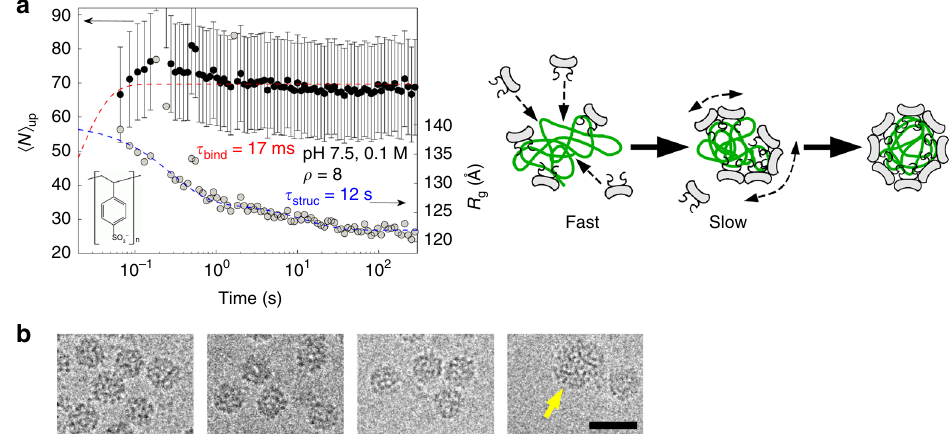
(black discs) and R g (light gray discs) vs. time after mixing subunits and 600-kDa poly(styrene Fig. 4 Self-assembly dynamics of PSS- fi lled capsids. a N h i up sulfonic acid) (PSS) at pH 7.5 with a fi nal ionic strength of 0.1 M. The subunit-to-PSS mass ratio was ρ = 8. The red and blue dashed lines are single and double exponential decay functions yielding τ bind and τ struc , respectively. The red dashed line starts from the origin since, in this experiment, N h i ( t = 0) = 0. Error bars are de fi ned as s.e.m. and were obtained by propagating the standard deviations of photon counts (see Methods). The chemical up structure represents the PSS repeat unit. The scattering patterns are shown on Supplementary Fig. 12. The drawing next to the graph depicts the en masse pathway with the subunits in light gray and the PSS in green. b Cryo-TEM images of PSS-loaded capsids obtained at ρ = 6 after a few days of incubation. The yellow arrow indicates a large species. Scale bar is 30